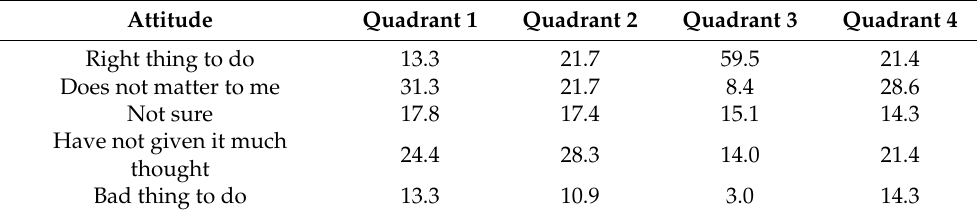
Table 5. I 3 classification and attitude towards trapping